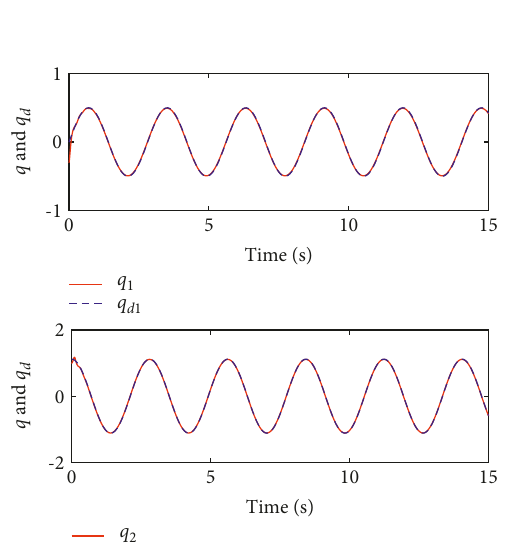
Figure 12: Profiles of CNN weights.